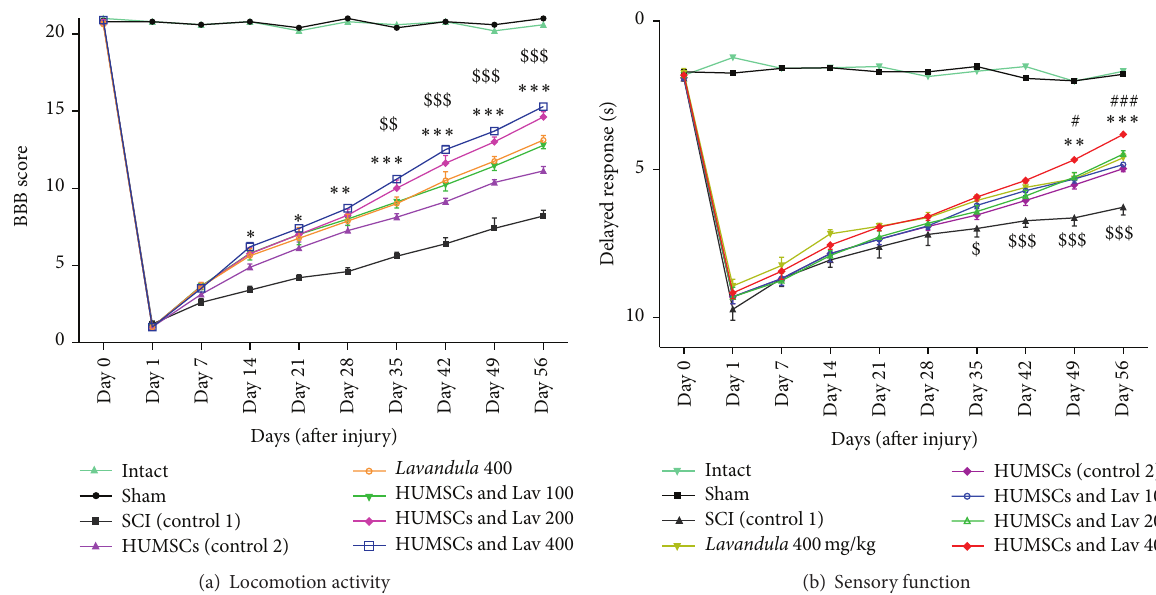
Figure 1: Administration of L. angustifolia extract improves motor and sensory function impairment in the rat spinal cord contusion model treated with HUMSCs. Administration of L. angustifolia extract (i.p.) daily for 14 consecutive days after injury significantly improved BBB scores (a) and sensory function (with decreased delayed response in the hot-water test) in HUMSCs treated animals (b). Data are represented as mean ± SEM. (a) ∗ , ∗∗ , and ∗∗∗ show significant differences of BBB scores between HUMSCs, HUMSCs + Lav 100, 200, and 400, and SCI group (control 1) ( 𝑃 < 0.05 , 𝑃 < 0.001 , and 𝑃 < 0.0001 , resp.). $ , $$ , and $$$ show significant differences of BBB scores between HUMSCs + Lav 100, 200, and 400, and HUMSCs treated group (control 2) ( 𝑃 < 0.05 , 𝑃 < 0.001 , and 𝑃 < 0.0001 , resp.). (b) ∗∗ and ∗∗∗ show significant differences of sensory function between HUMSCs and SCI group (control 1) ( 𝑃 < 0.001 and 𝑃 < 0.0001 , resp.). # and ### show significant differences of sensory function between HUMSCs + Lav 400 and HUMSCs treated group (control 2) ( 𝑃 < 0.05 and 𝑃 < 0.0001 , resp.). $ , $$ , and $$$ show significant differences of sensory function between HUMSCs + Lav 400 and SCI group (control 1) ( 𝑃 < 0.05 , 𝑃 < 0.001 , and 𝑃 < 0.0001 ,